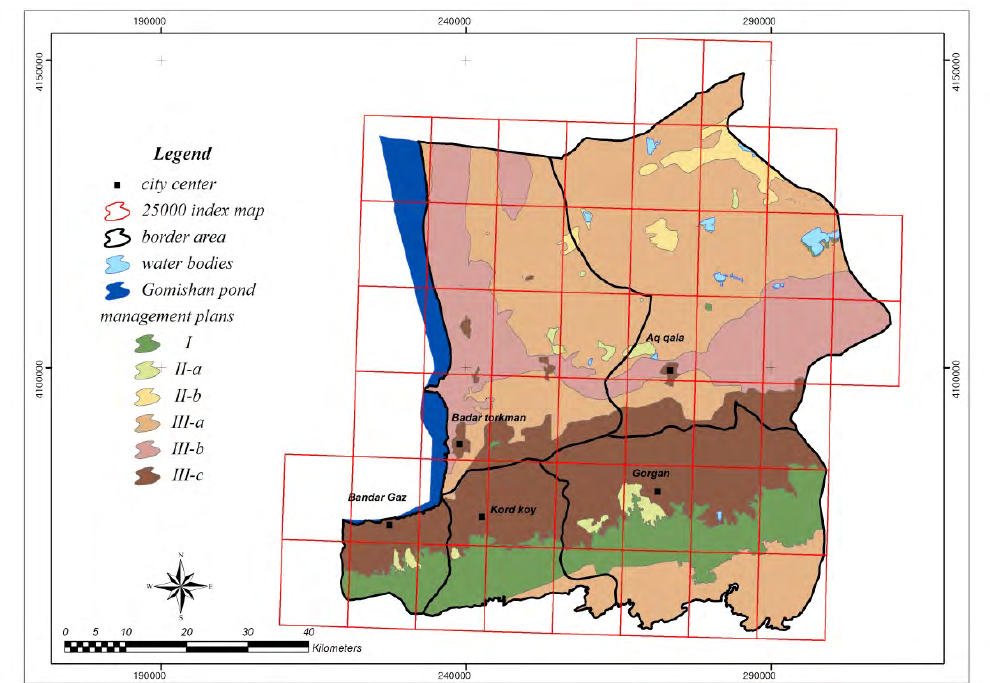
Fig. 7: Management plan map of the study